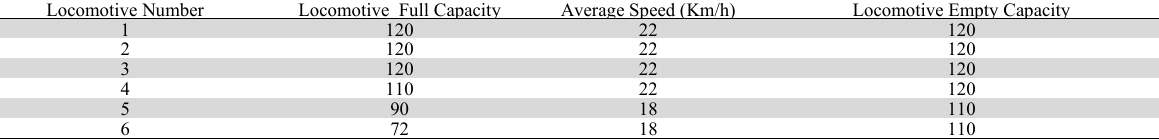
Locomotives capacity and